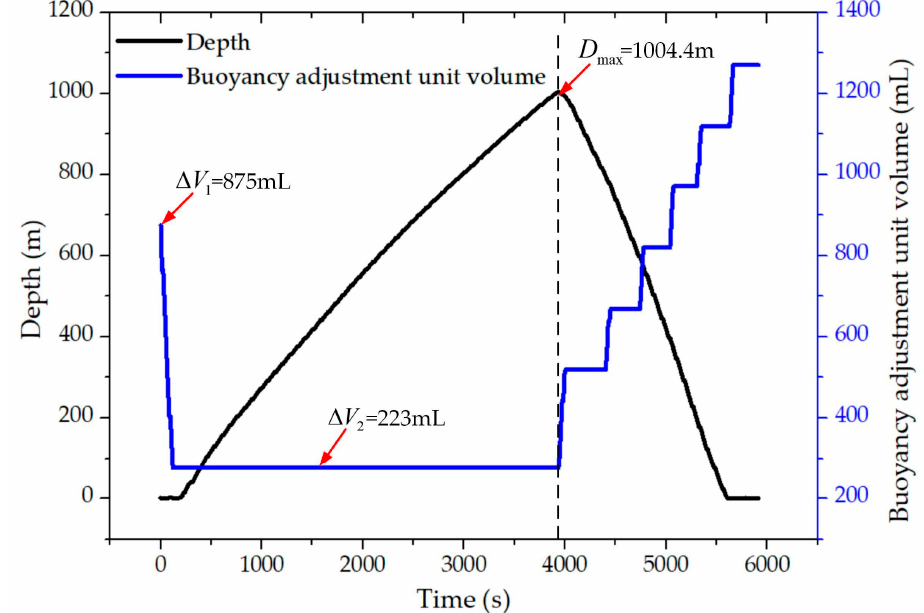
Figure 15. The depth and buoyancy adjustment unit volume curves of the profile.